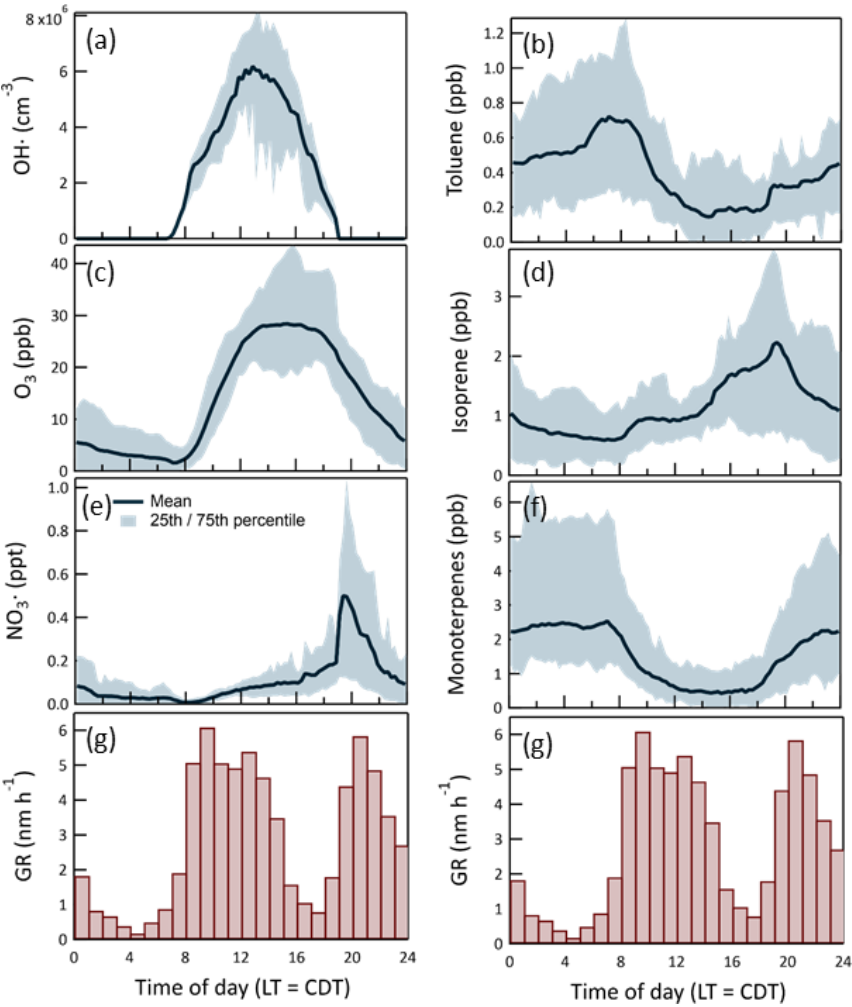
Figure 17. Time of day-dependent mean and 25th/75th percentiles for the most important oxidants (a) , (c) , (e) and secondary organic aerosol precursors (b) , (d) , (f) . Hourly averaged particle growth rates during the 2016 study are shown at the bottom (g) . A total of 1973 values were used to construct the